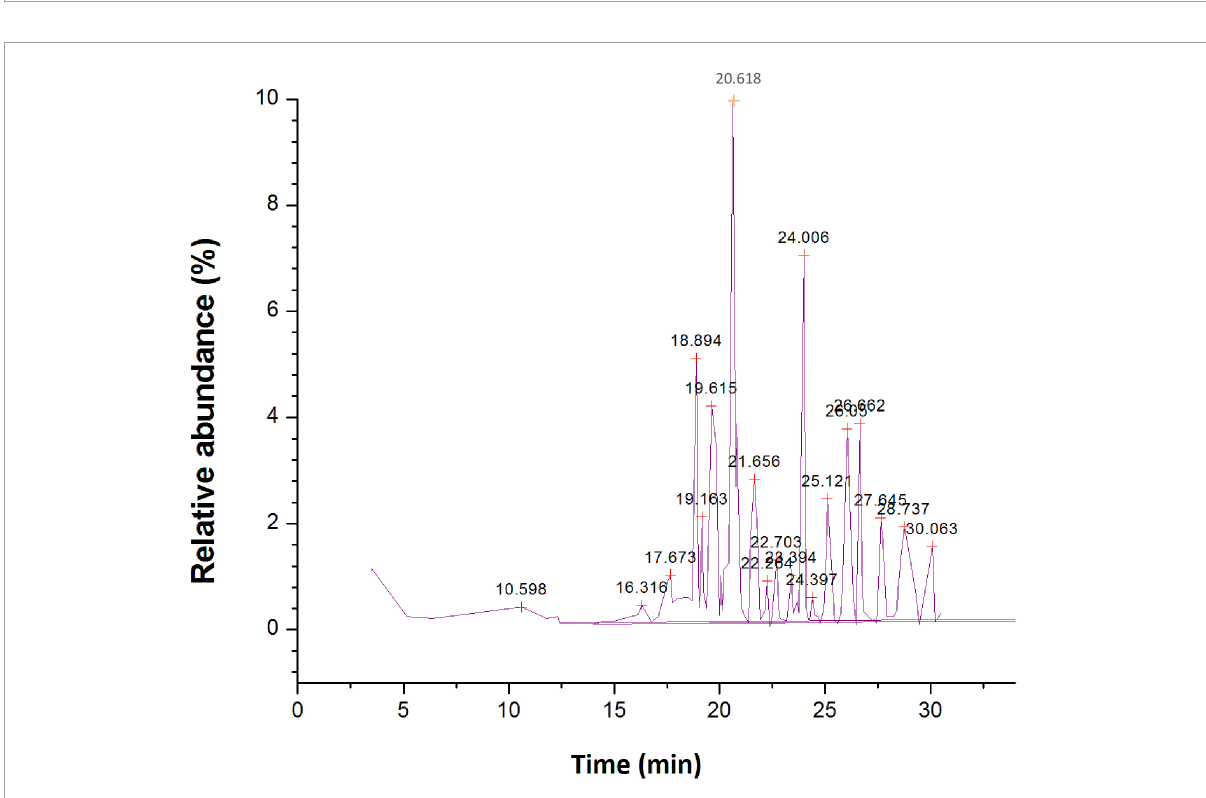
FIGURE6 Gas chromatography-mass spectrometer (GC-MS) chromatogram for major compounds of ethyl acetate root extract of Skimmia anquetilia